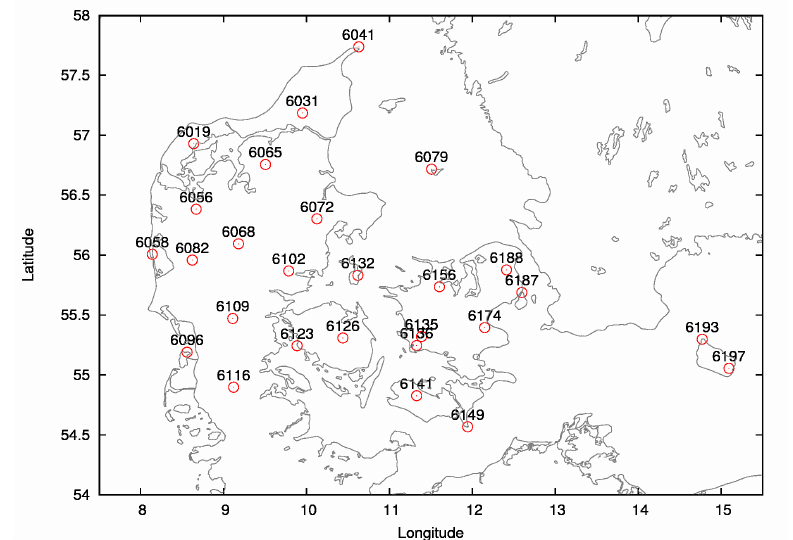
Figure 2. Danish GHI stations. The numbers are the WMO station